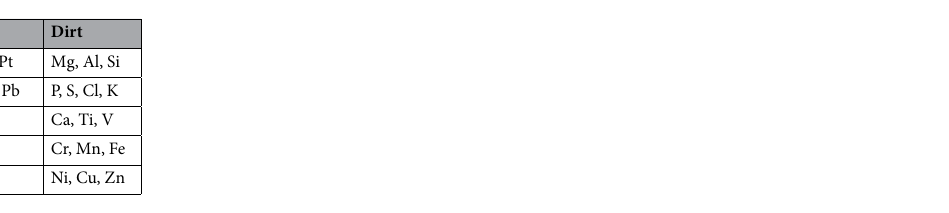
Figure 1. (a) Optical image of coin B, where the XRF map was collected, (b) fluorescence emission induced with an exciting beam of 10 keV in the area shown in panel a : the emission energy range corresponds to the Au M lines, the intensity follows a temperature scale, (c) superposition of panels ( a ) and ( b ), (d) the three groups found in the t-SNE analysis: blue for G1, red for G2, green for G3, (e) superposition of panel ( a ) and ( d ), and (f) superposition of panel d and a grey scale version of ( b ).